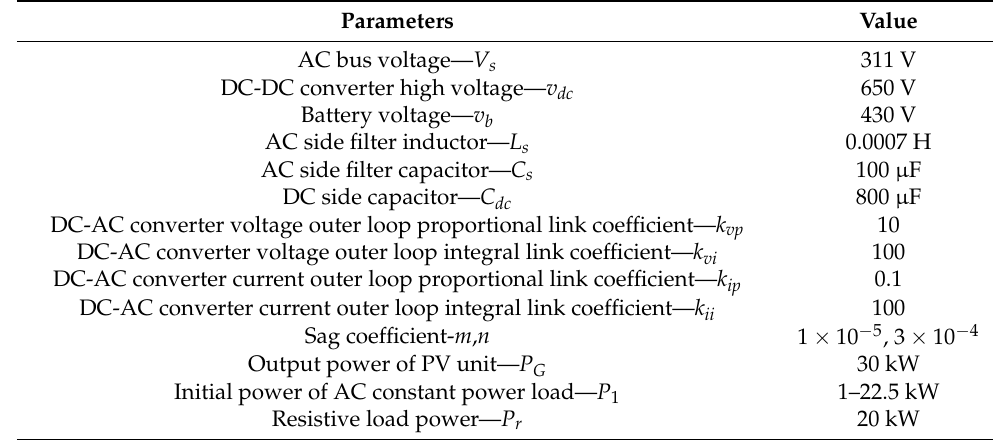
Table 1. Parameters of AC microgrid simulation